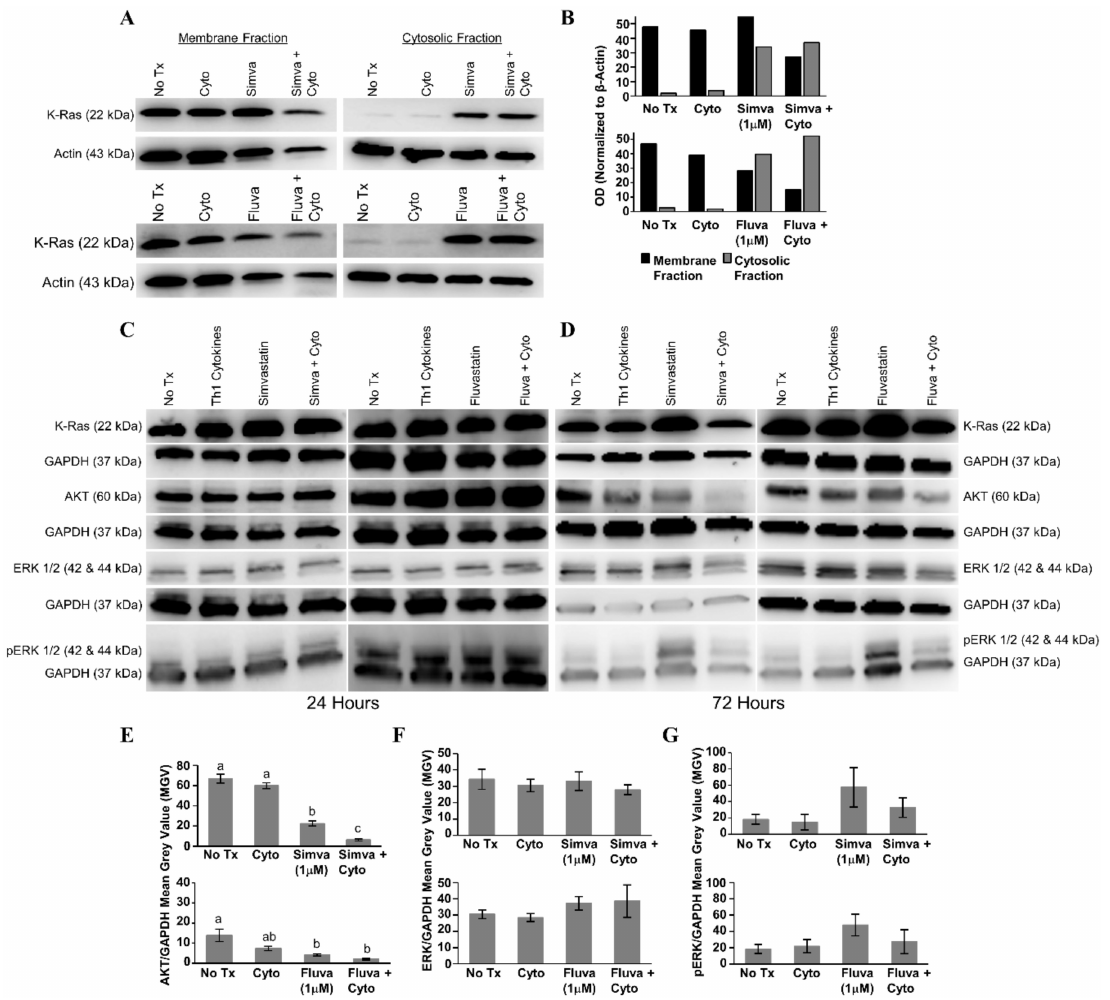
Figure 7. Combined treatment with Th1 cytokines and statin drugs potentiates K-Ras delocalization from membrane. MDA-MB-231 human breast cancer cells were cultured with no additives (No Tx), treated with recombinant Th1 cytokines (TNF- α and IFN- γ , 10 ng / mL each), a statin drug (Simvastatin or Fluvastatin, 1 µ M), or the combination of Th1 cytokines and a statin drug (“Simva + Cyto” or “Fluva + Cyto”) for 24 h. Membrane proteins were separated from cytosolic proteins and the distribution of the K-Ras protein was analyzed by Western blot. ( A ) Representative Western blot images and ( B ) corresponding semi-quantitative densitometry analysis of K-Ras normalized to β -actin loading control. Representative Western blot images of whole-cell K-Ras, AKT, ERK 1 , and phospho-ERK 1 after ( C ) 24 and ( D ) 72 h of treatment. Semi-quantitative densitometry analysis 2 2 of the ( E ) GAPDH-normalized total AKT, ( F ) GAPDH-normalized total ERK-1 / 2, and ( G ) GAPDH-normalized phosphorylated ERK-1 / 2. All Western blot experiments were repeated at least three times. Displayed graphical